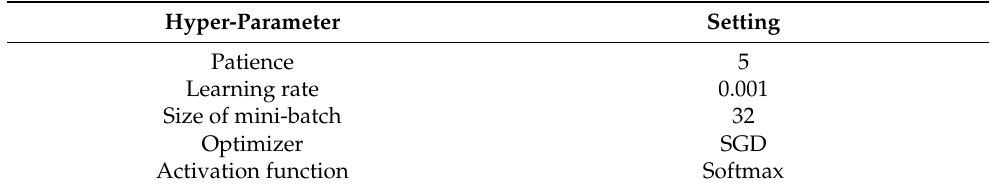
Table 4. The hyper-parameter setting for EfficientNet architectures.